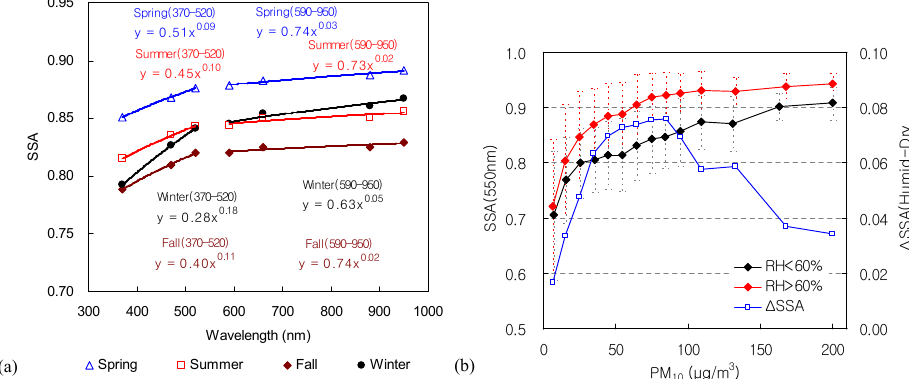
Fig. 8. Seasonal variations of (a) aerosol single scattering albedo (SSA) as a function of wavelength and (b) SSA at 550nm wavelength as a function of PM 10 mass concentration under relatively dry (RH < 60%) and humid (RH > 60%) conditions, respectively.